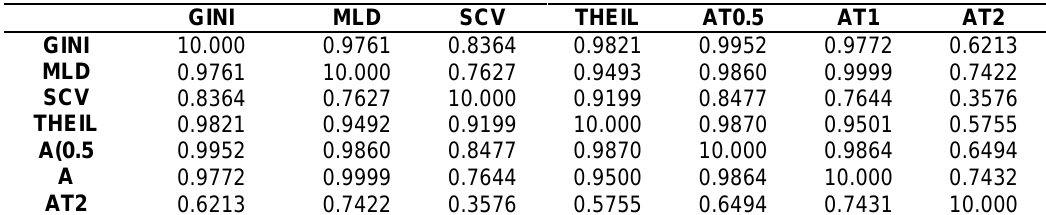
Table 2. Correlation coefficients of several inequality measures for the EU-28 countries in 2012. Source: Own elaboration based on statistics from the European